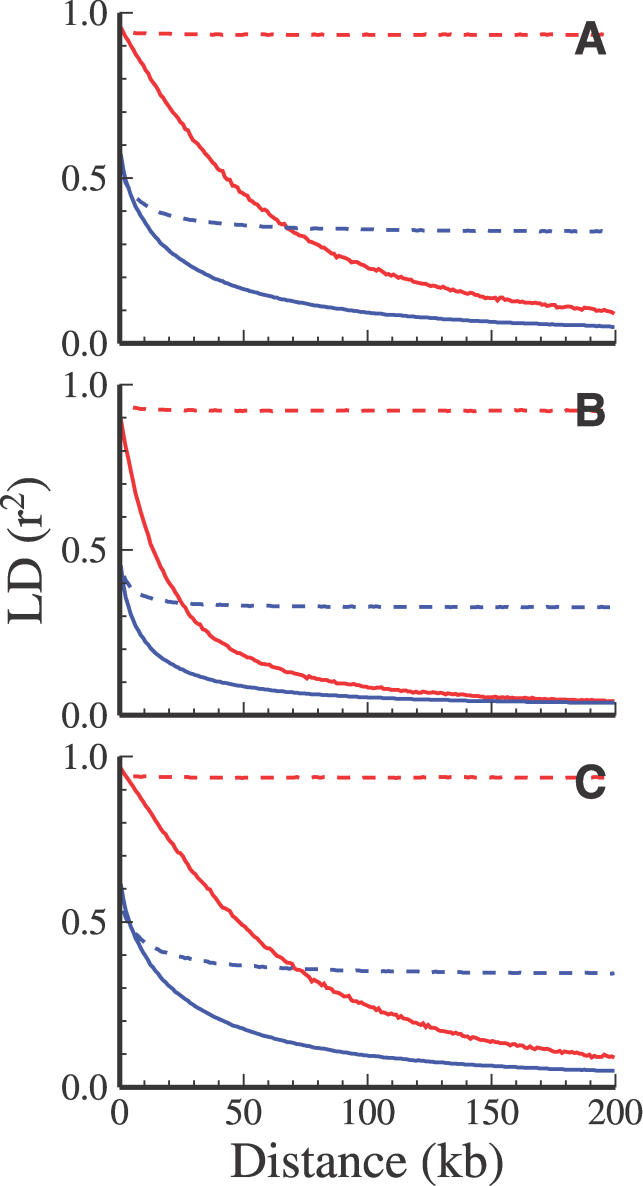
Average Linkage Disequilibrium (r
2) versus Distance between MarkersLinkage disequilibrium (r
2) in the European (A), African-American (B), and Han Chinese (C) populations. Solid blue lines are average LD values in 1-kb bins excluding SNPs with minor allele frequencies below 0.1, and the dashed blue lines are the theoretical maximum values calculated using the frequency values of all SNP pairs. The red lines are the same except SNP pairs with different minor-allele frequencies were excluded.